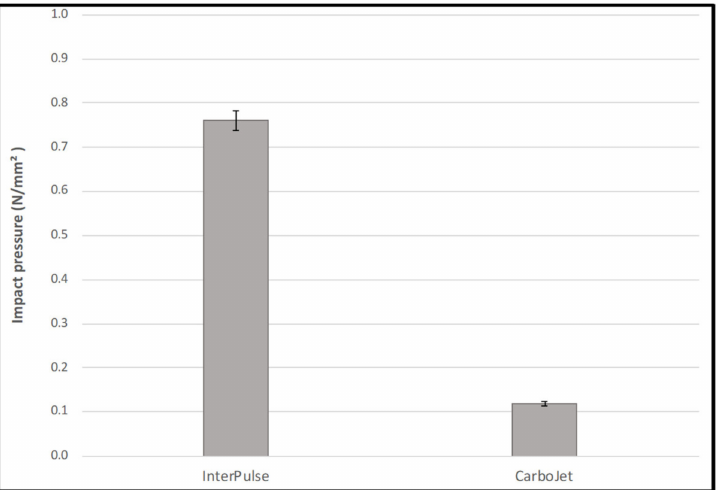
Figure 5. Impact pressure in N/mm 2 .